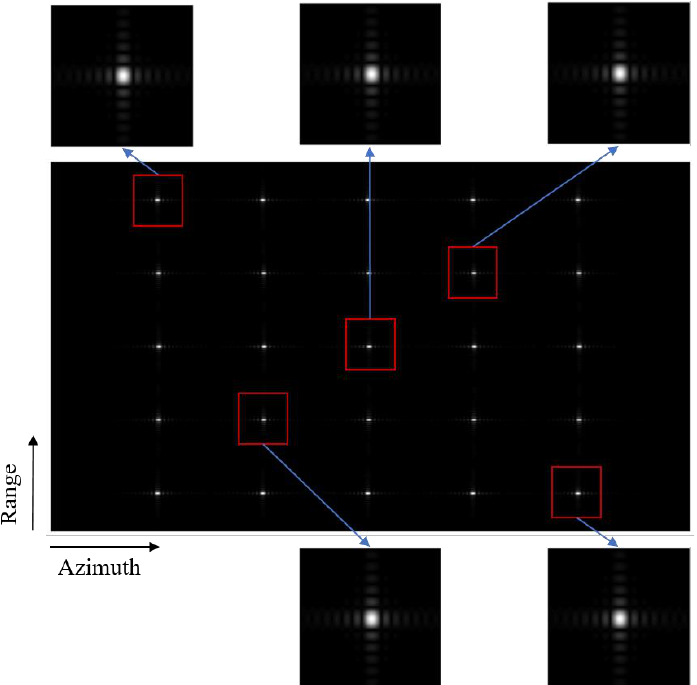
Figure 21. The distribution of twenty-five point targets at perigee.